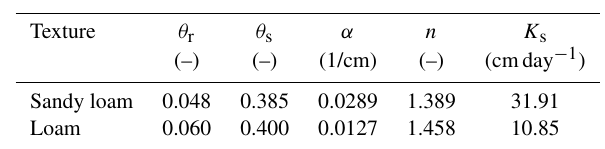
Table 2. The van Genuchten parameters used in the Hydrus-1D sim-